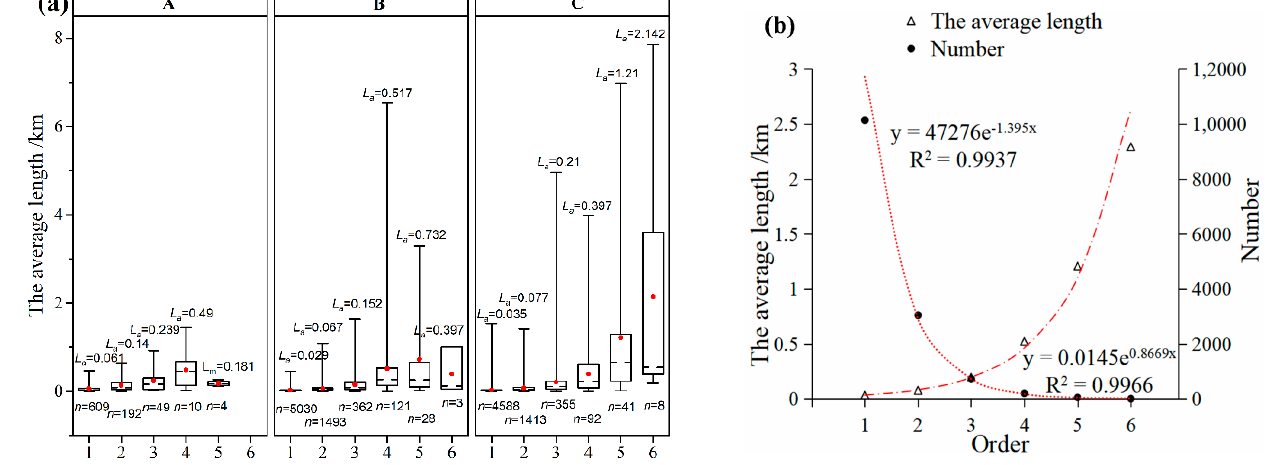
Figure 8. ( a ) Average length-number boxplot and ( b ) fitting analysis of tidal creeks of different orders in the coastal wetlands of the Liao River Estuary ( L a : average length of tidal creeks; n : number of tidal creeks; A: the supratidal zone; B: the upper intertidal zone; C: the middle intertidal zone).